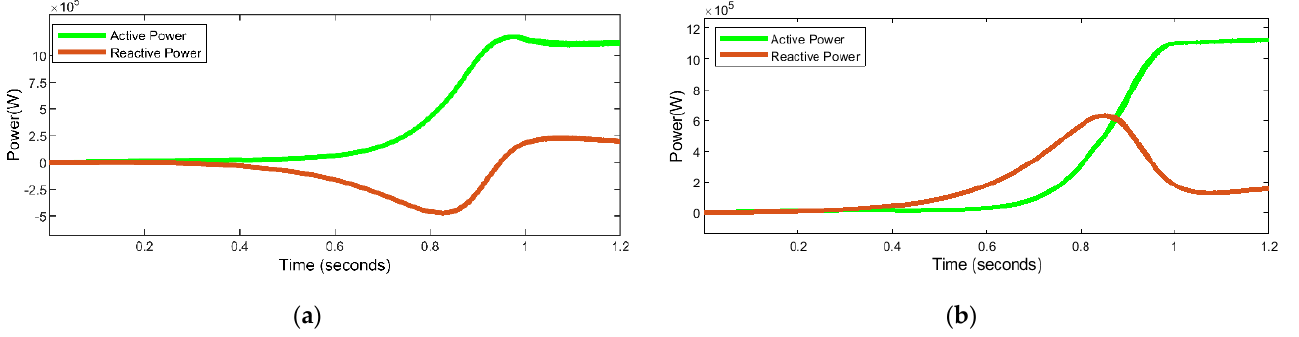
Figure 11. The controller adjusts some parameters and performance to optimize and stabilize the active power and reactive power in a certain bounded range: ( a ) DG1; ( b ) DG2.